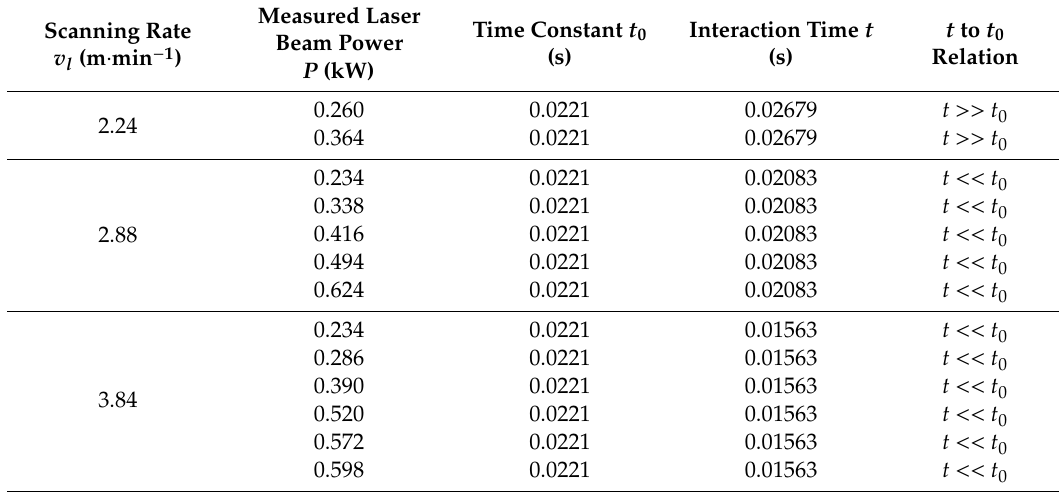
Table 2. Influence of laser heat treatment parameters on time constant t 0 and interaction time t